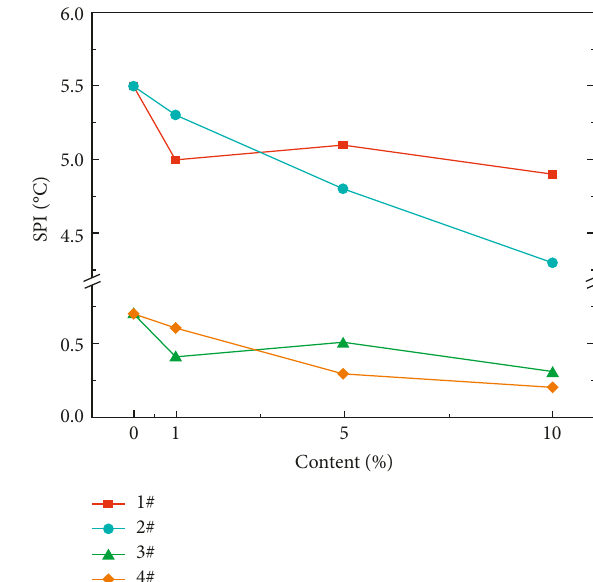
Figure 5: SPI of different